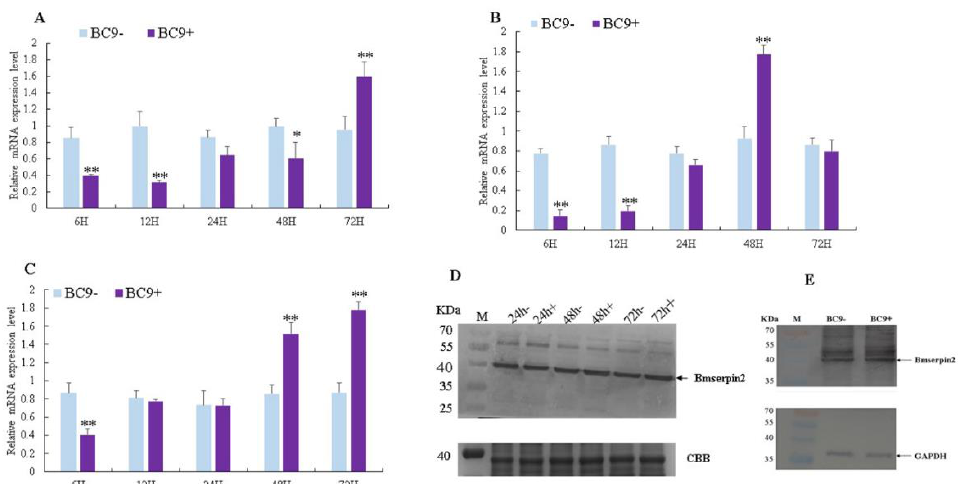
Figure 4. Expression profiles of the Bmserpin2 in BC9 (resistant strain) after BmNPV infection in the haemolymph ( A ), fat body ( B ) and midgut ( C ) at 6, 12, 24, 48 and 72 hpi. BC9 − was used as a control. Relative expression levels were calculated using the 2 −∆∆ Ct method. Statistical analysis was performed using SPSS software. Significant differences are indicated by * ( p < 0.05) or ** ( p < 0.01). Western blot analyses were performed in haemolymph ( D ) 24, 48 and 72 hpi, total proteins were Coomassie Brilliant Blue (CBB)-stained as the loading control and midgut ( E ) at 24 hpi. Anti-GAPDH was used as the loading control.